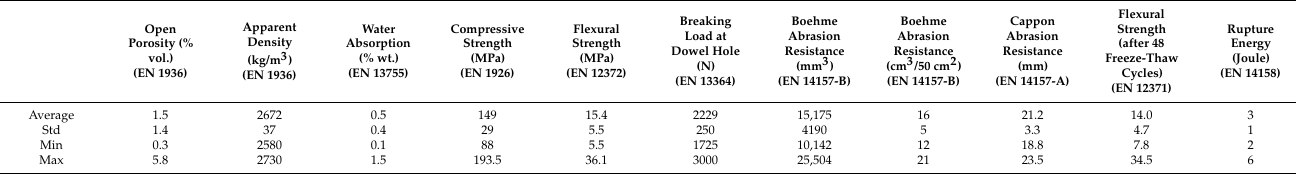
Table 3. Average values of physical mechanical properties determined for compact limestones.